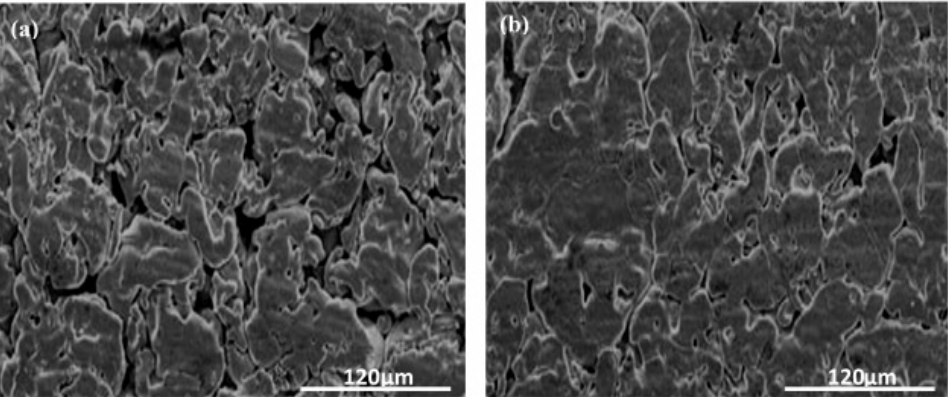
Figure 15. Surface morphology of sintered sponge iron powder (NC) specimens; (a) compacted at 300 MPa, (c) compacted at 600